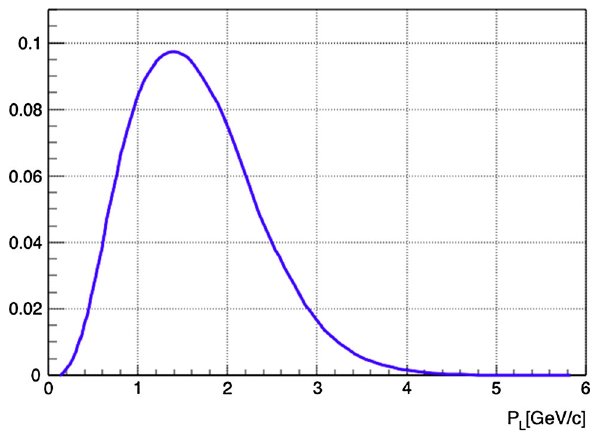
Fig. 3 Momentum distribution of the (cid:4) cc baryons produced by the intrinsic charm from the target with a 200 GeV/c proton